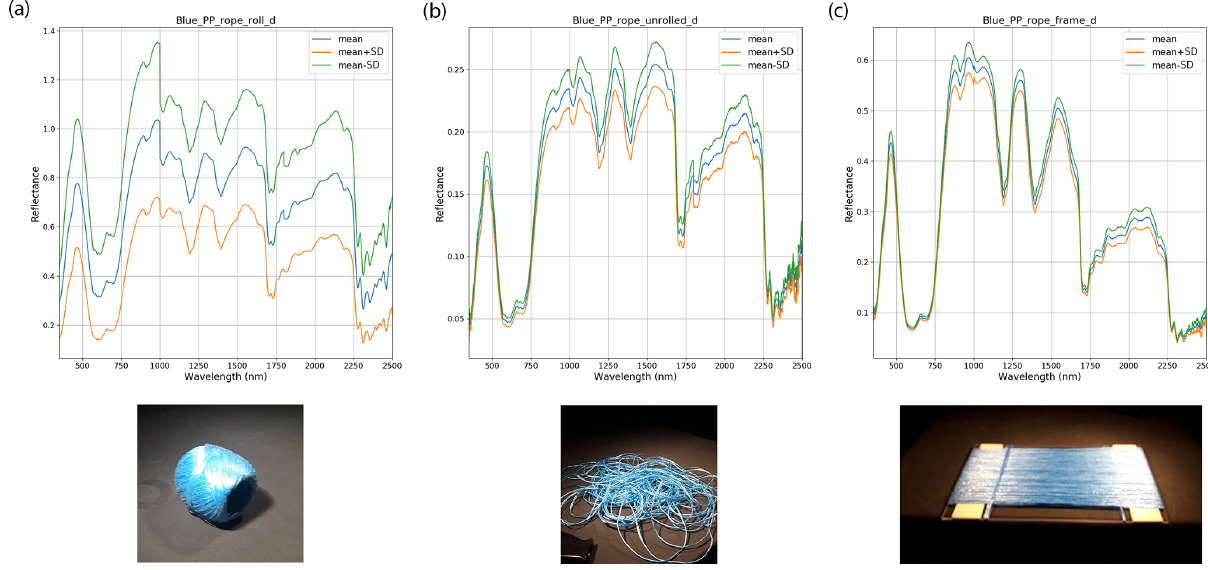
Figure 8. Mean and SD for the blue rope in three conditions: on a roll as bought in the store, unrolled and aligned on a plexiglass